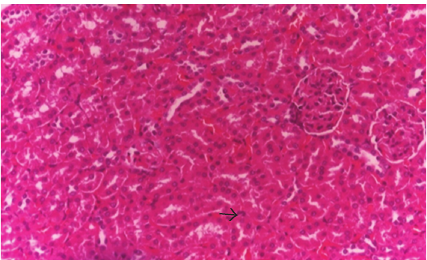
Figure 2: Representative microscopic tissue images of proximal tubule epithelium. Rats were given 50 mg/kg/day NaNO 2 and 0,016 mg/mL Cu-chlorophyllin (H&E). Necrosis cell (black arrow). Photographs were obtained by light microscopy at 400 × magnifica-